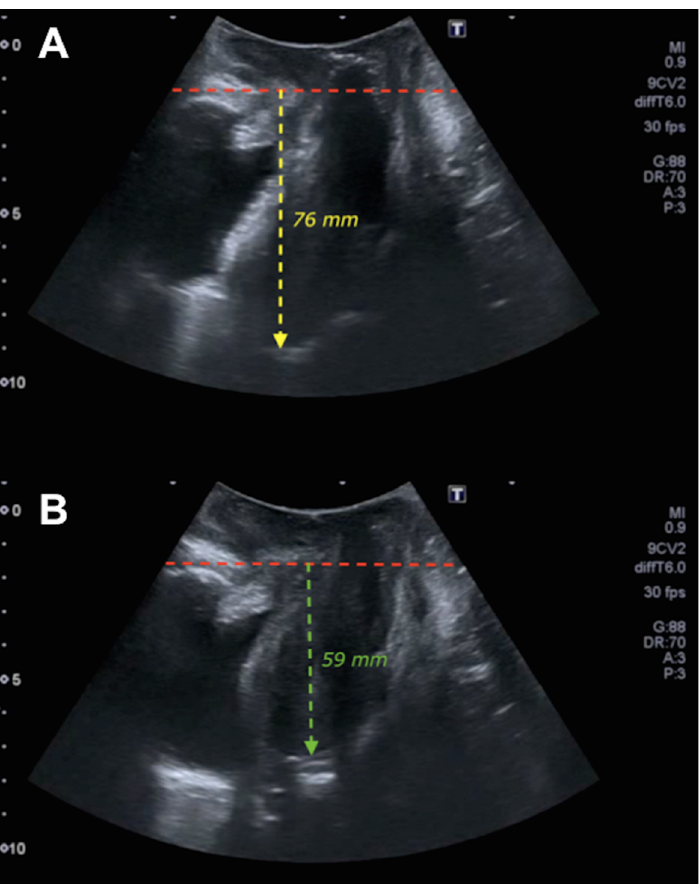
Figure 1. Ultrasound of uterine prolapse. Figure A shows the midsagittal plane of the pelvic floor at rest where the red line delimits the posteroinferior margin of the pubis and the yellow line the pubis–fundus distance at rest. Figure B shows the midsagittal plane of the pelvic floor in Valsalva where the red line establishes the posteroinferior margin of the pubis and the green line the pubis–fundus distance in Valsalva.